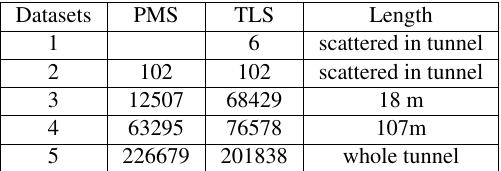
Figure 10: Portion of the 3D model of the side wall and the be- ginning of the vault obtained with PMS using the sequences of right images (from the side-looking stereo rig and the top-looking stereo rig with − 32 ◦ angle). The poses are shown for each cam- era location, behind the 3D sparse, textured model. Table 1: Number of points in both models for each dataset.